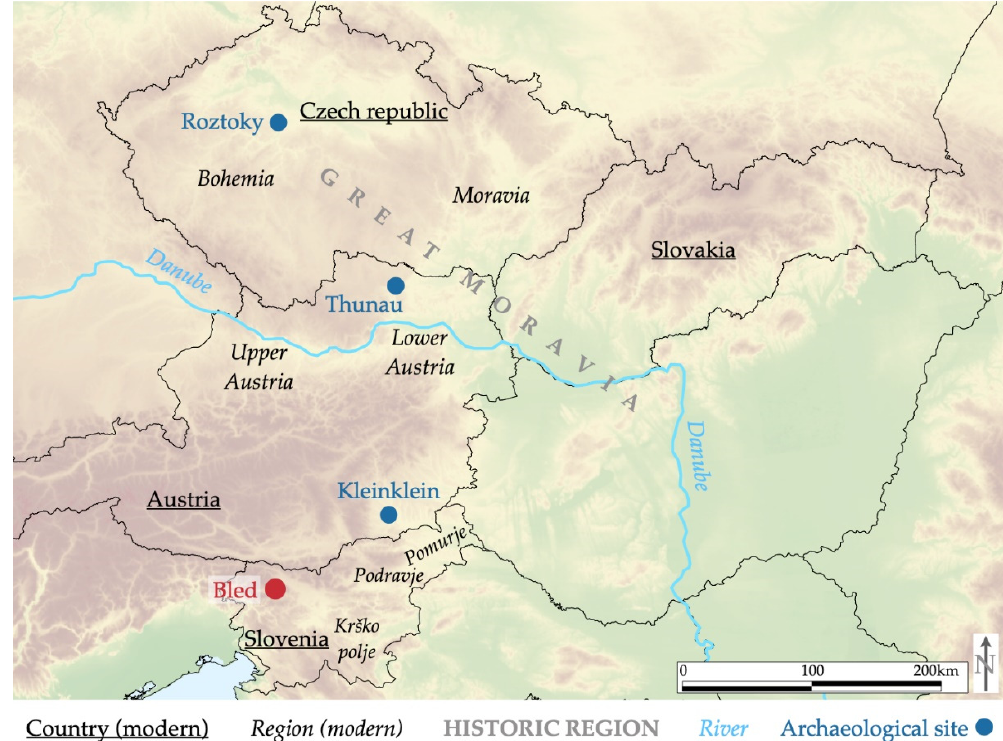
Figure 2. Regional map of locations and sites mentioned in the comparative studies (decimal longitude and latitude coordinates of the map centre: 17.8173; 47.8235).